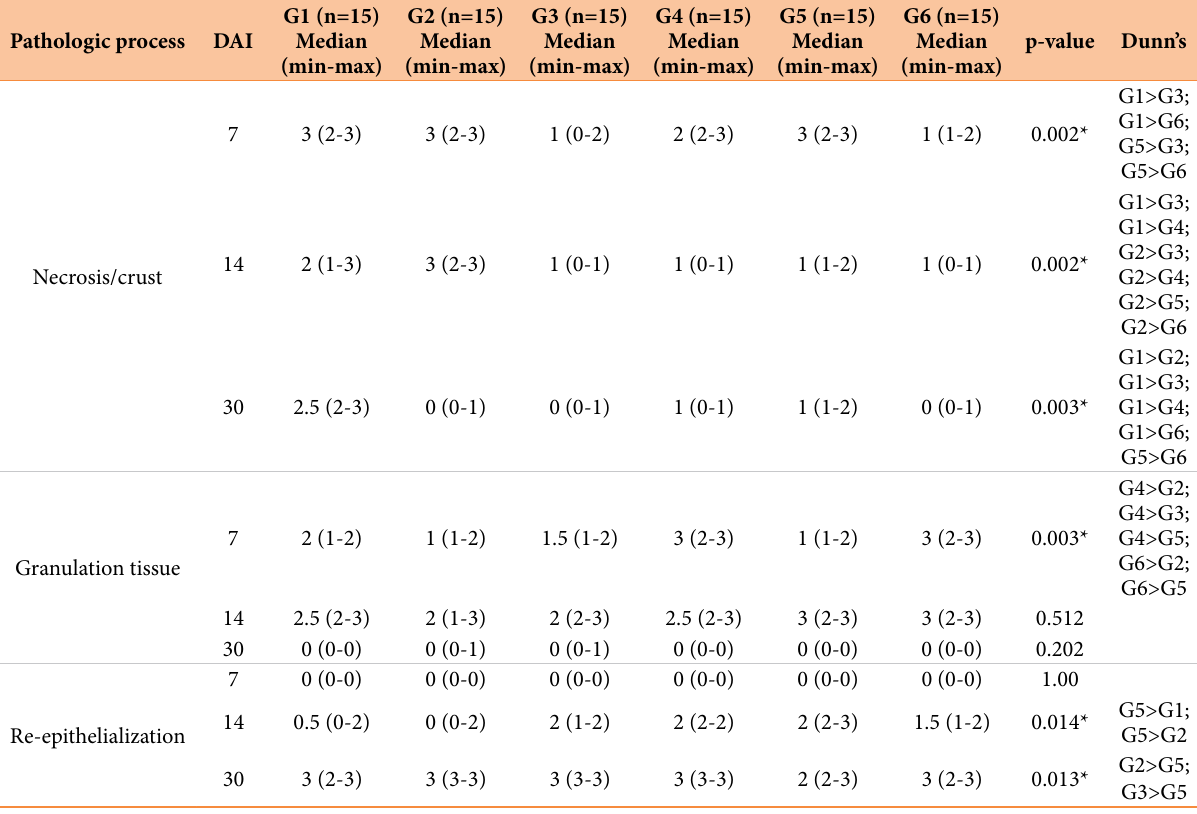
Table 2 - Macroscopic analysis of partial thickness burn wounds experimentally induced in Wistar rats treated with calcium and/or sodium alginate hydrogel-based dressings # .